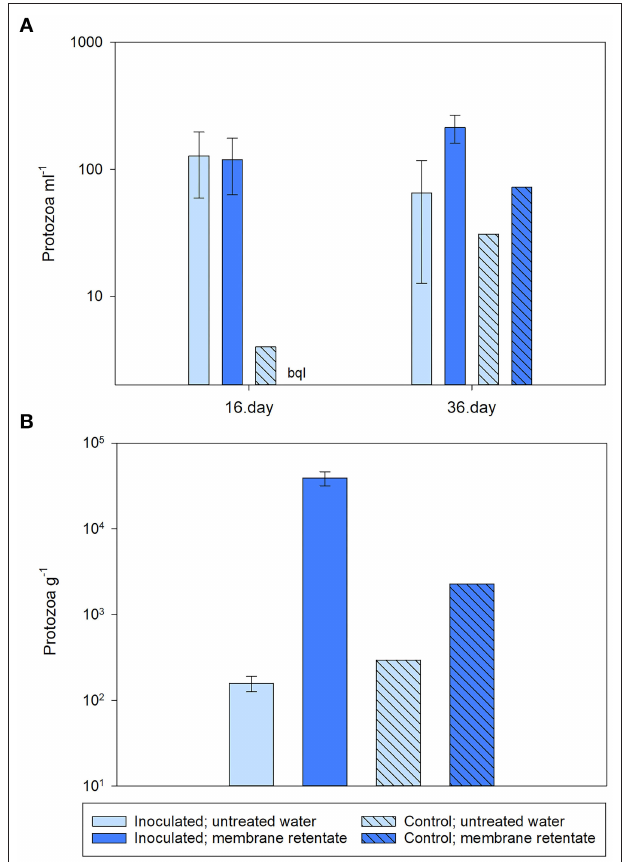
FIGURE 5 | Number of culturable protozoa in (A) the column effluent and (B) the sand of the columns at experimental termination. Columns received during operation a feed of either untreated water with 0.3 µ g l − 1 BAM (light blue bars) or membrane retentate water with 3.0 µ g l − 1 BAM (dark blue bars). For the columns inoculated with Aminobacter sp. MSH1 data are presented as means ( n = 3) with error bars showing standard error. Two control columns were run without initial inoculation (hatched bars; n = 1). bql: below quantification limit.